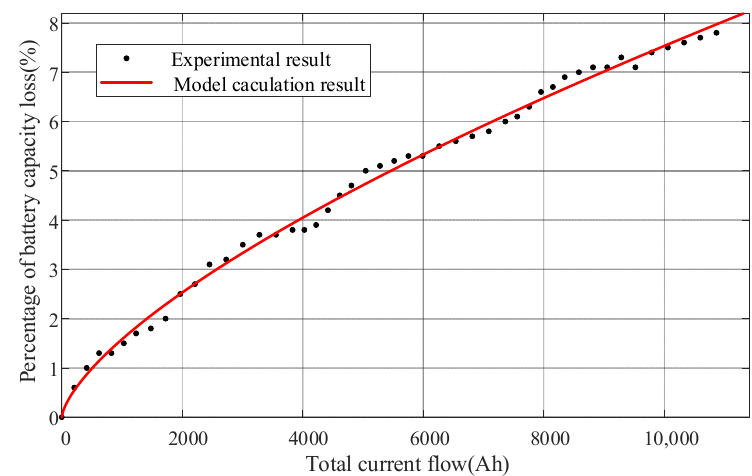
Figure 5. Battery capacity decay curve.